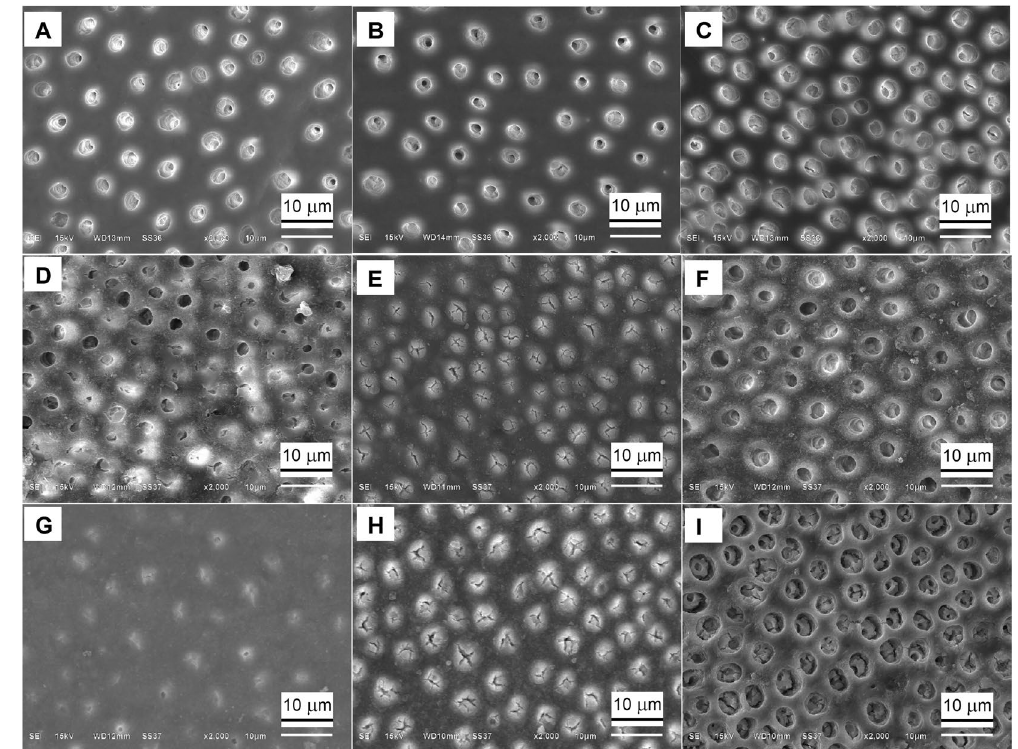
Figure 2. ( A – I ) Scanning electron micrographs of cross sectional views of human dentin (original magnification × 2000). ( A ) Treated with 17% EDTA; ( B ) treated with distilled water for 7 days; ( C ) applied with distilled water and cathode iontophoresis for 7 days; ( D – F ) applied with stannous fluoride without iontophoresis; ( G – I ) applied with stannous fluoride and cathode iontophoresis at ( D , G ) immediate treatment, ( E , H ) 7 days and ( F , I ) acid